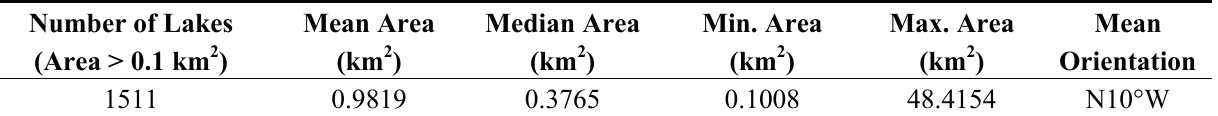
Table 1. Summary statistics for the number, area, size and orientation of oriented thermokarst lakes on the ACP [18].